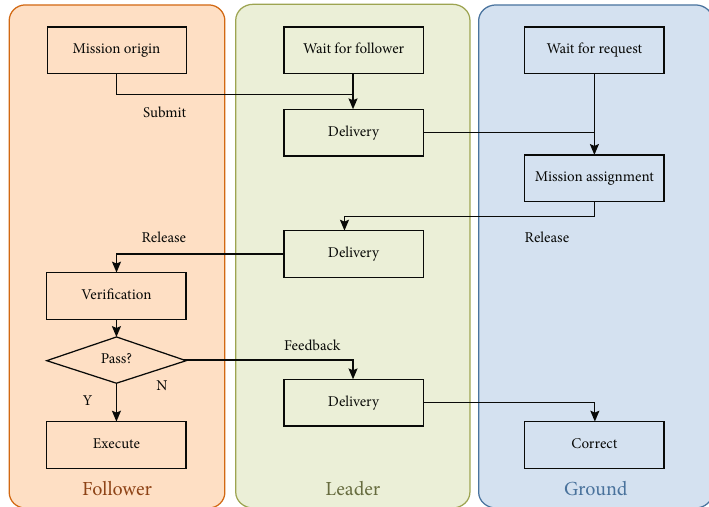
Figure 3: Ground-based mode